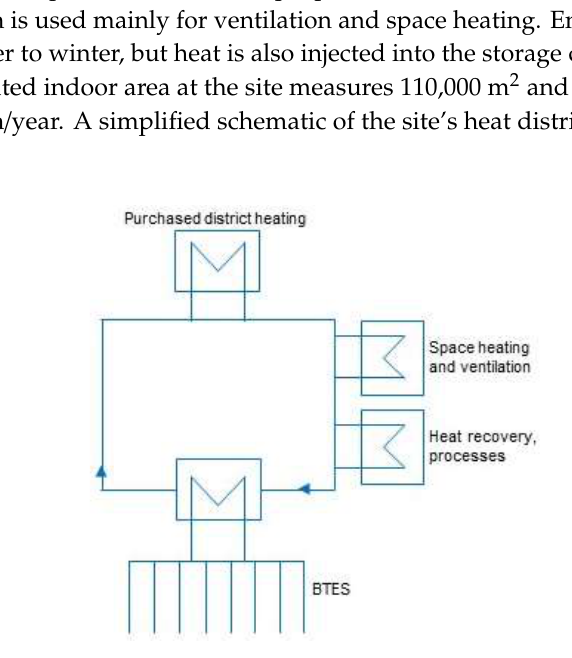
Figure 1. Heat distribution network at Xylem, Emmaboda.